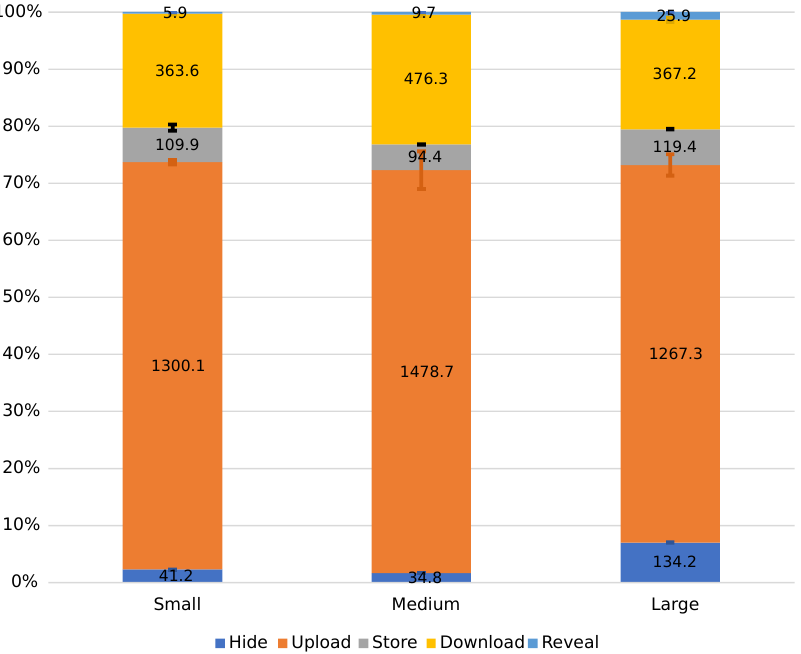
Figure 4. Runtimes (in milliseconds) per step and image size, normalized to